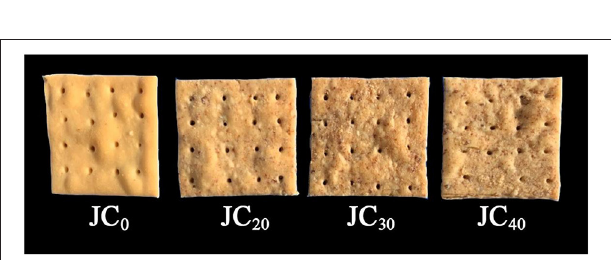
FIGURE 2 | Characteristics of cracker samples.